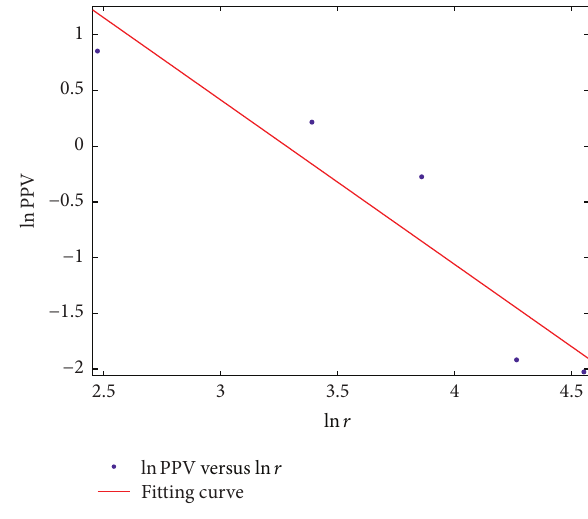
Figure 10: Curve of fitted data. Table 1, change law of vibration velocity with distance from blasting center can be fitted by least square